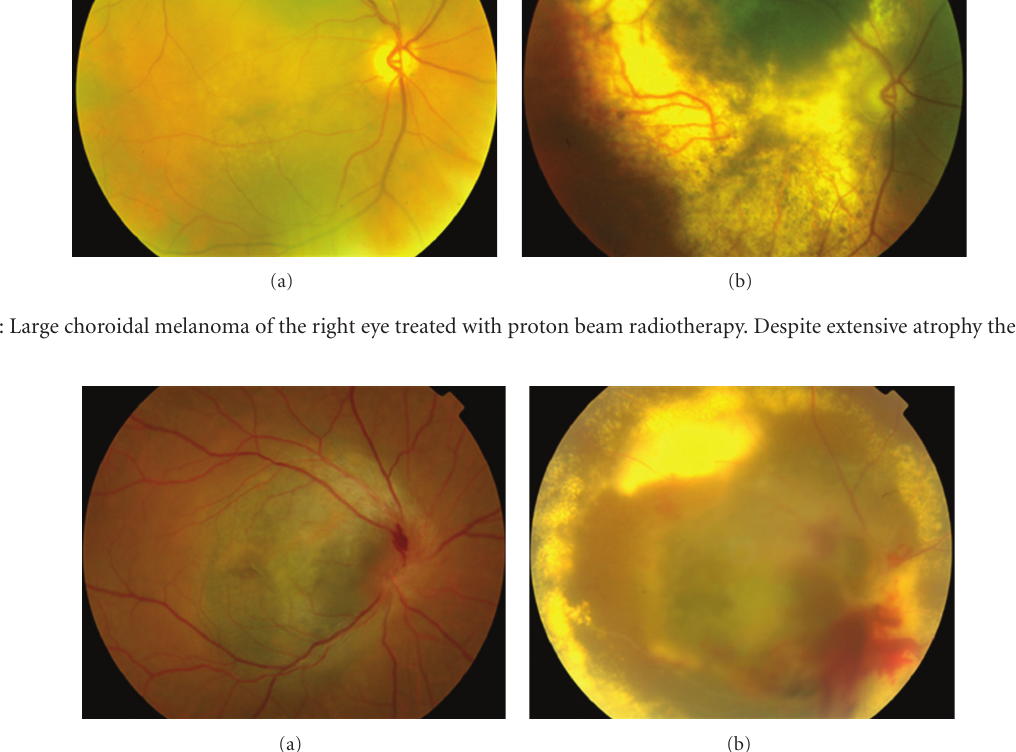
Figure 11: Large juxtapapillary lesion treated with proton beam radiotherapy. Extensive radiation retinopathy and papillopathy developed